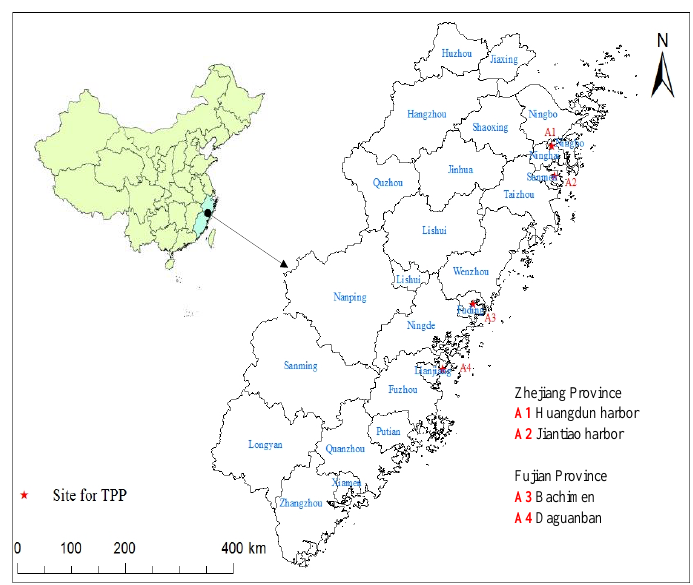
Figure 2. The distribution of the four ideal sites.